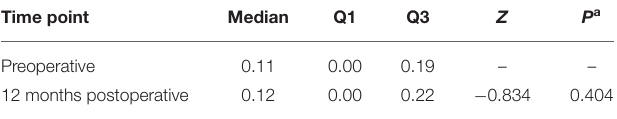
TABLE 2 | Changes in the BCVA (LogMAR) before and after